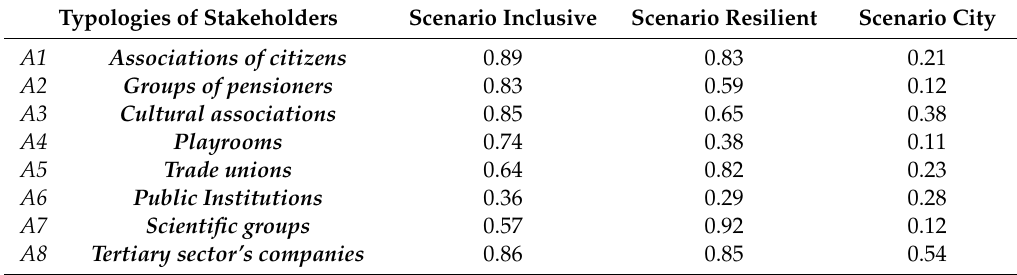
Table 5. Classification of the scenarios corresponding to the higher consent